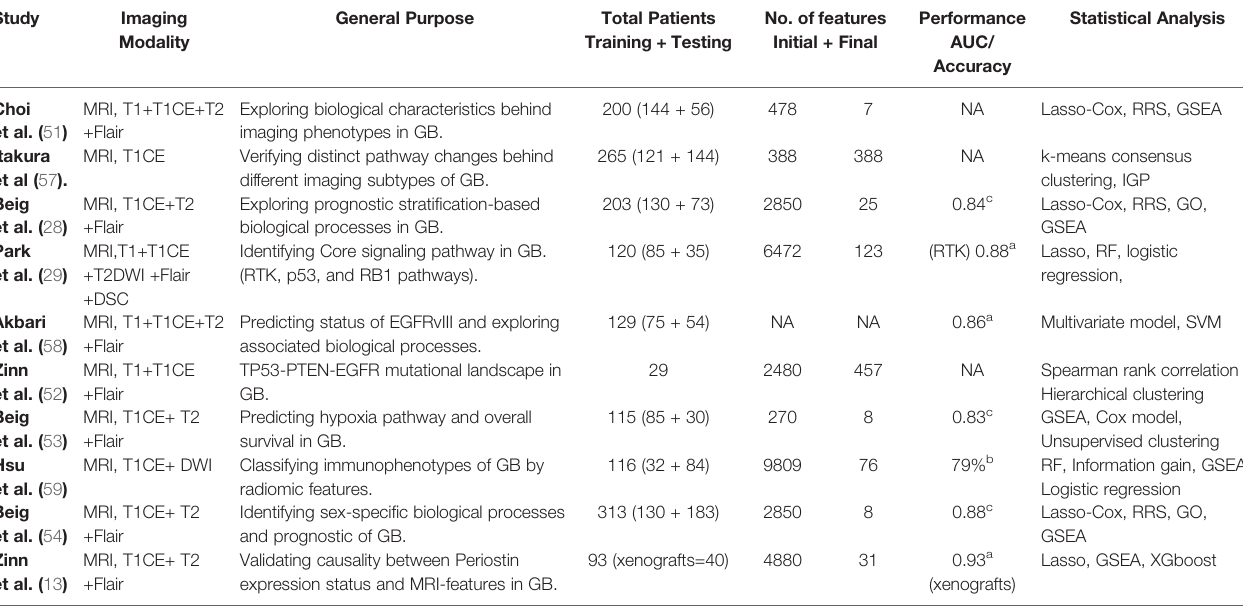
TABLE 2 | Applications of imaging-genomics for exploring potential signaling pathway or biological processes or in GB.